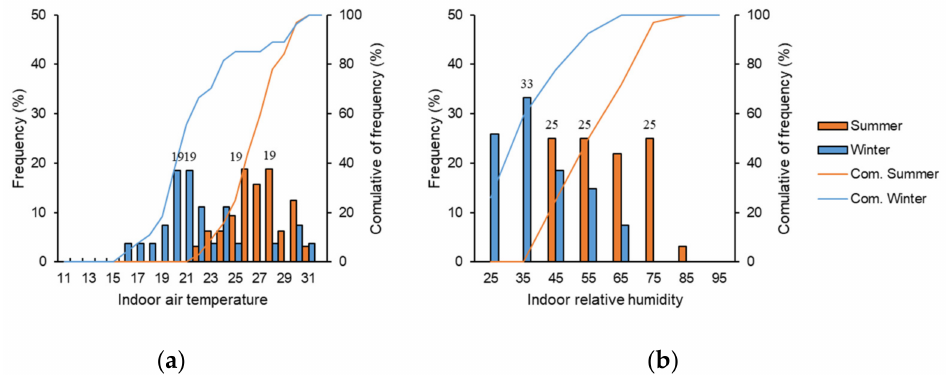
Figure 4. Frequency distribution of the ( a ) indoor air temperature and ( b ) relative humidity; Abbre- viation: Com., cumulative.